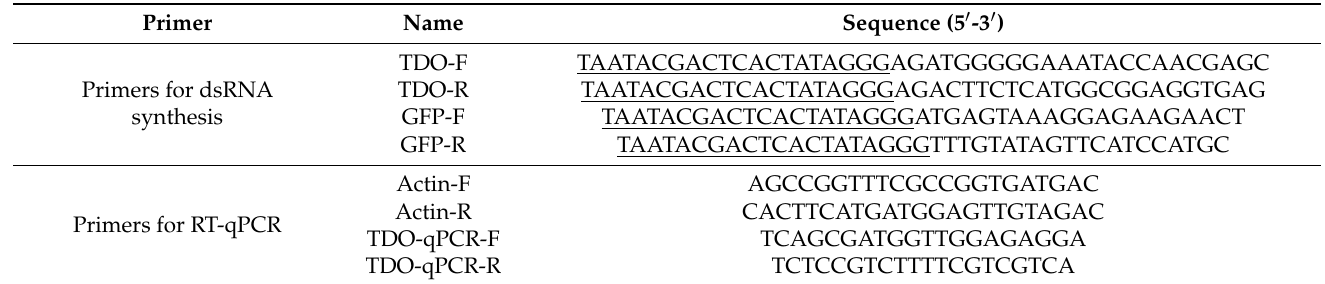
Table 1. List of primer